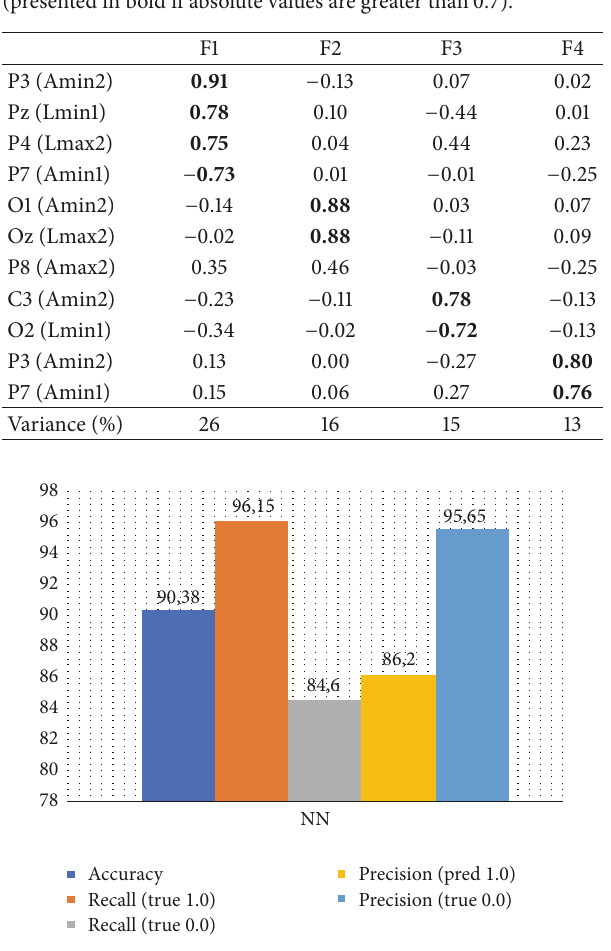
Figure 3: Neural Network (NN) performance measures with Factor Analysis (FA).